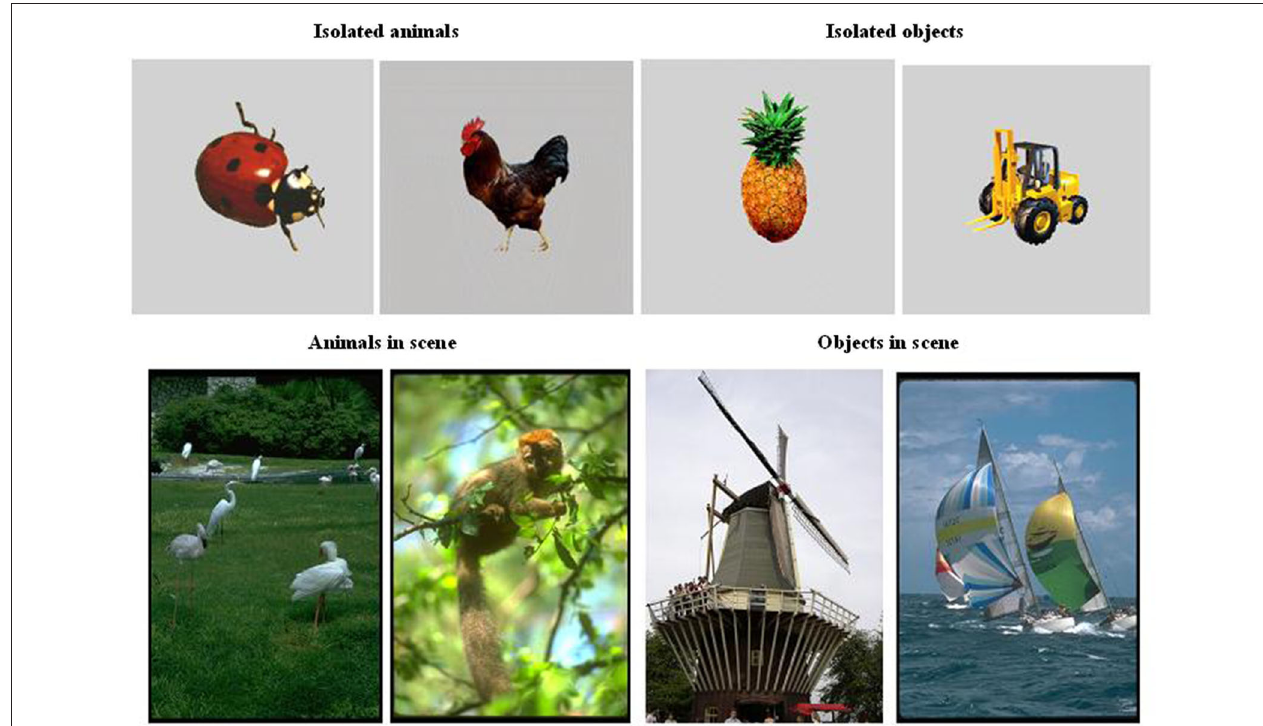
FIGURE 1 | Examples of stimuli (animals and objects) used in the categorization tasks (saccade and manual responses) .